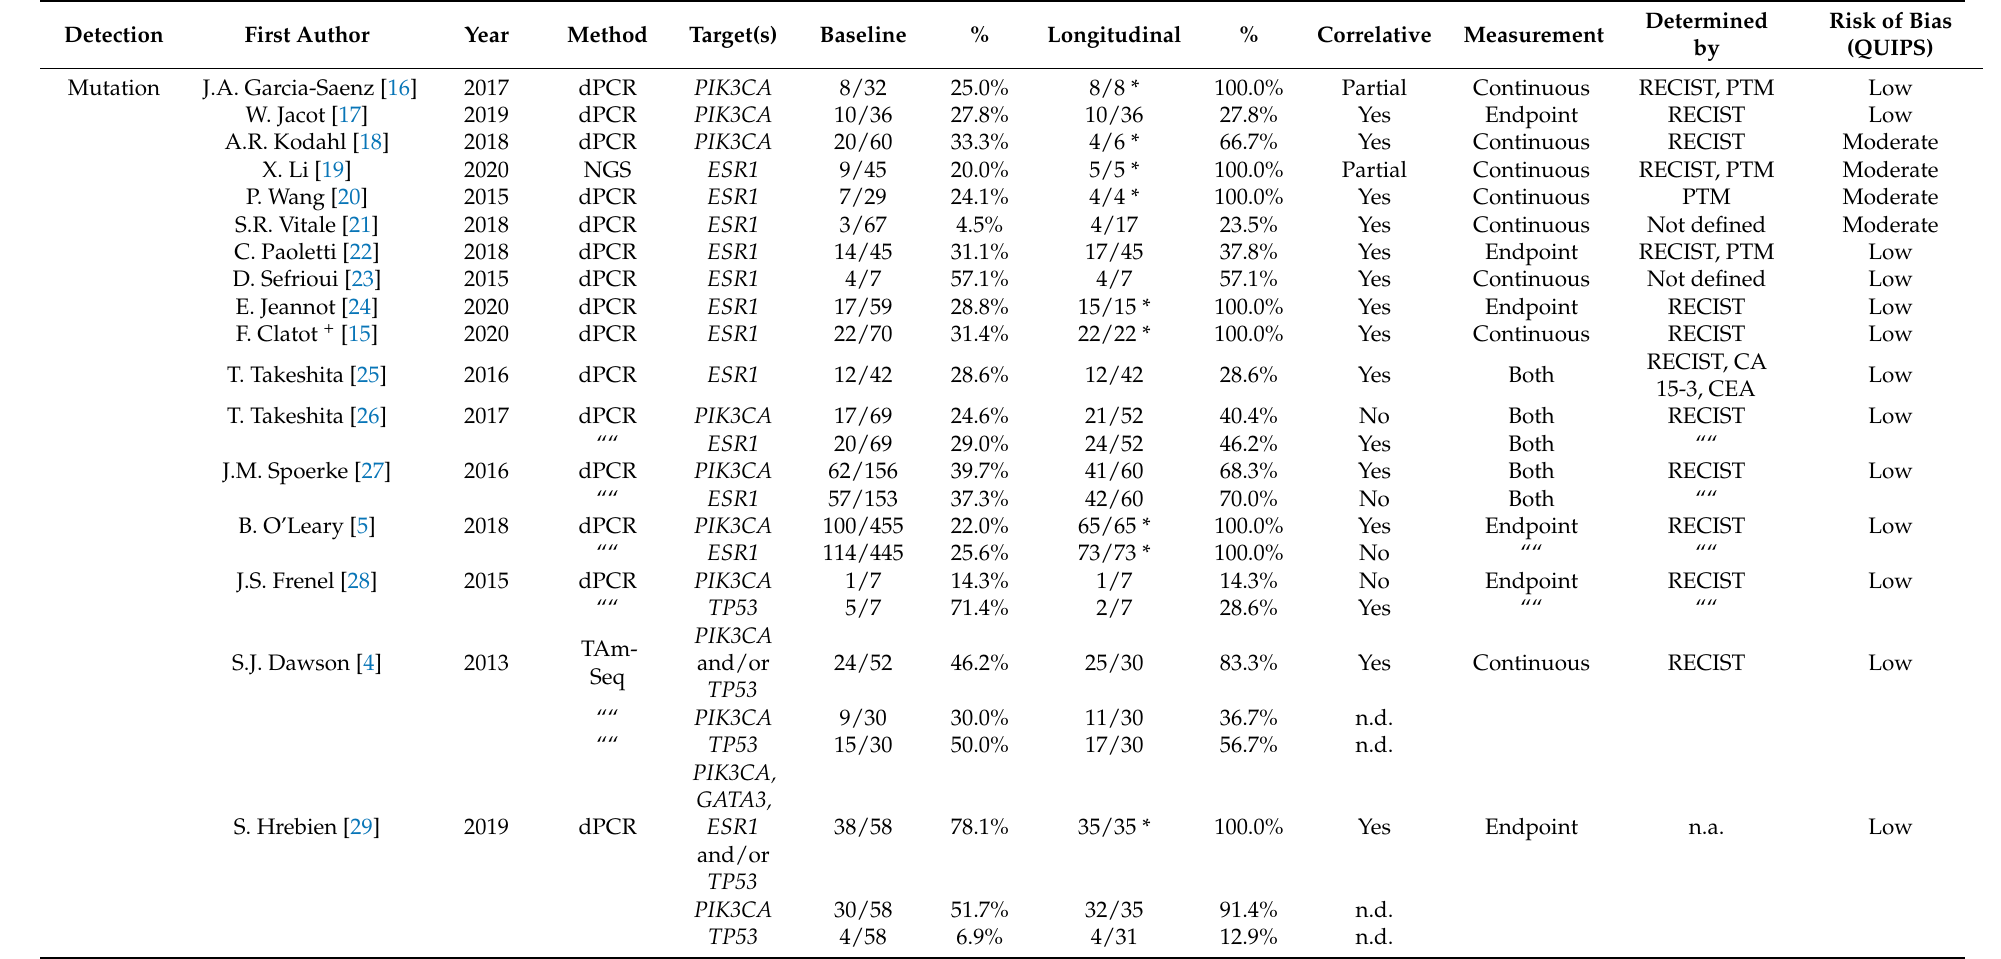
Table 1. Published studies on cfDNA monitoring in